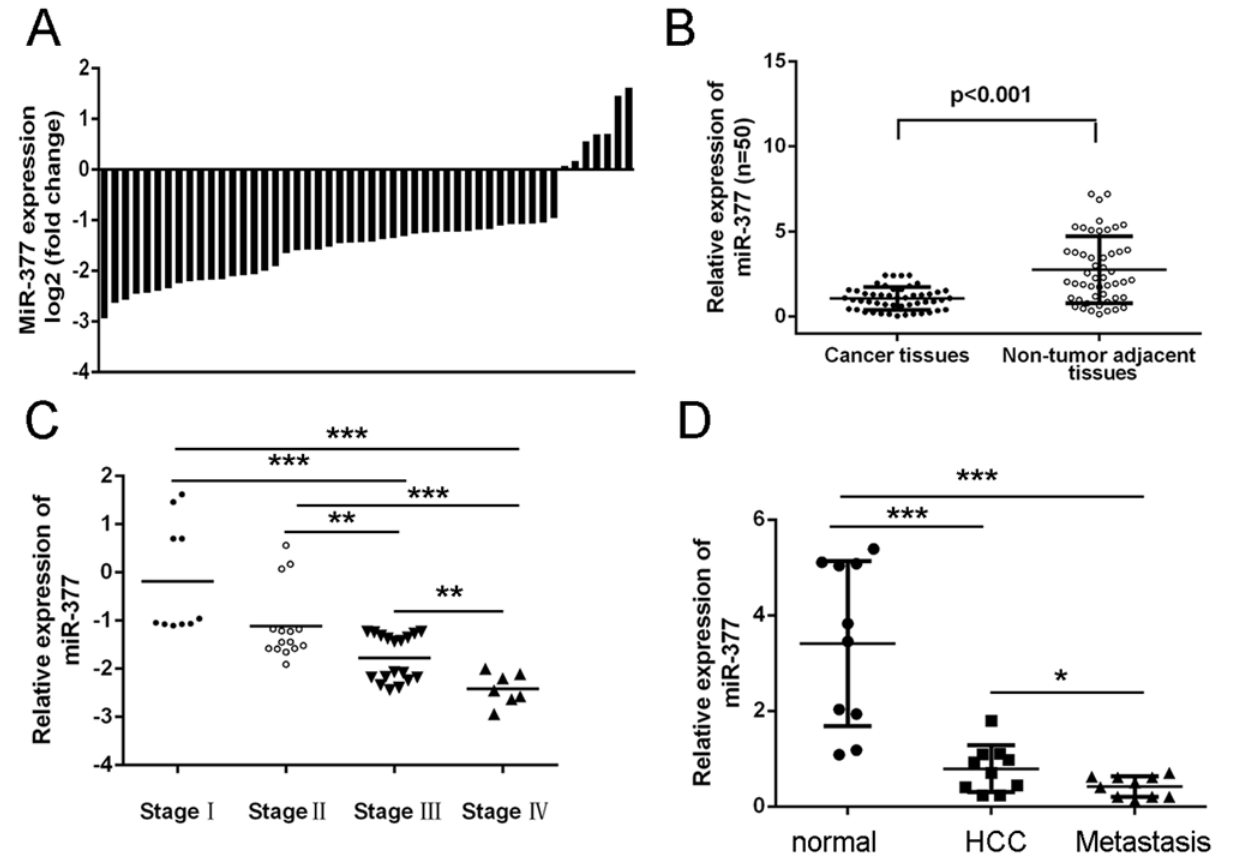
Fig 2. Expression of miR-377 in clinical HCC patients and correlation analysis with clinicopathological characteristics. (A) miR-377 was detected in 50 pairs of HCC tissues and its adjacent normal controls by quantitative RT-PCR. Data are presented as log2 of fold change of HCC tissues relative to adjacent normal regions. U6 snRNA was used as internal control. (B) Relative miR-377 expression levels in HCC tissues and adjacent normal tissues were determined by qRT-PCR. (C) The Statistical analysis of the association between miRNA level and pTNM stage (I, II, III and IV). (D) The relative expression of miR-377 in adjacent normal tissues, primary HCC tissues and lymph node metastatic tissues from 10 patients. * p < 0.05, and ** p < 0.01, *** p < 0.001.